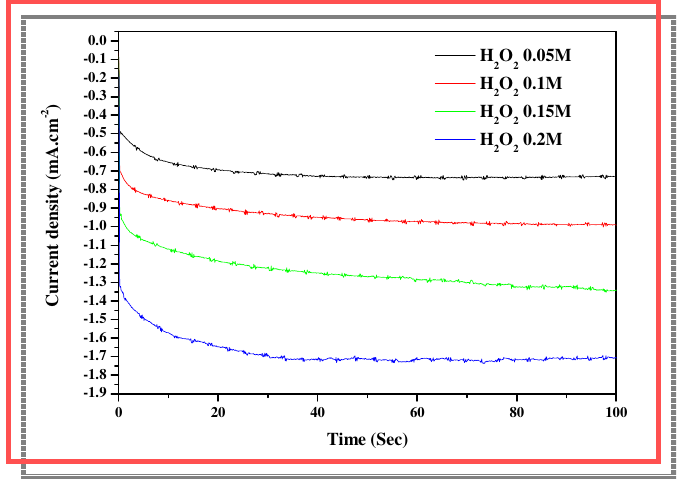
Figure 5. Amperometric responses as a function of concentration of H